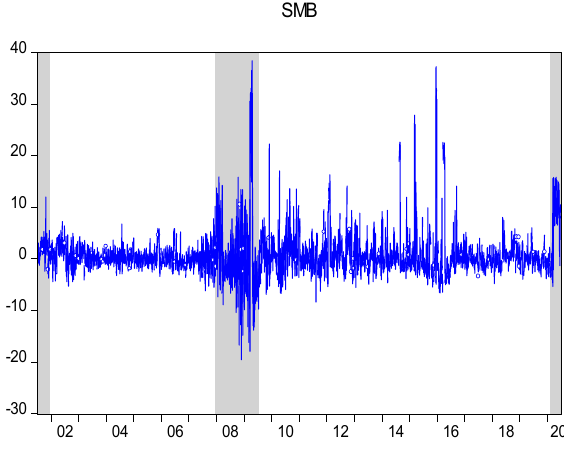
Figure 1. Time series variation in SMB premiums.